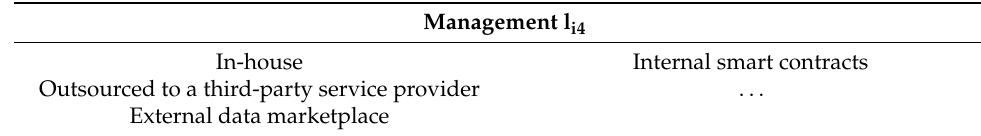
Table 5. Asset Omni-management model—Management.